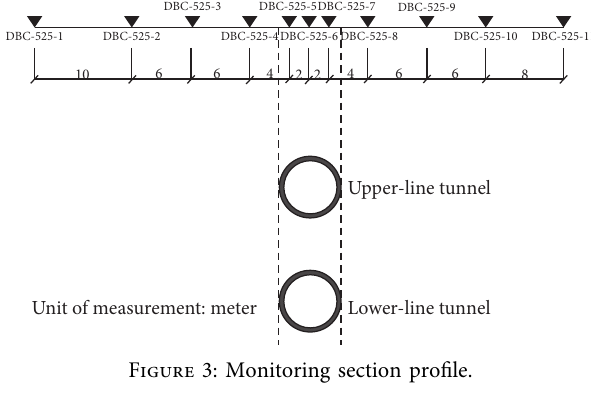
Figure 3: Monitoring section profile.